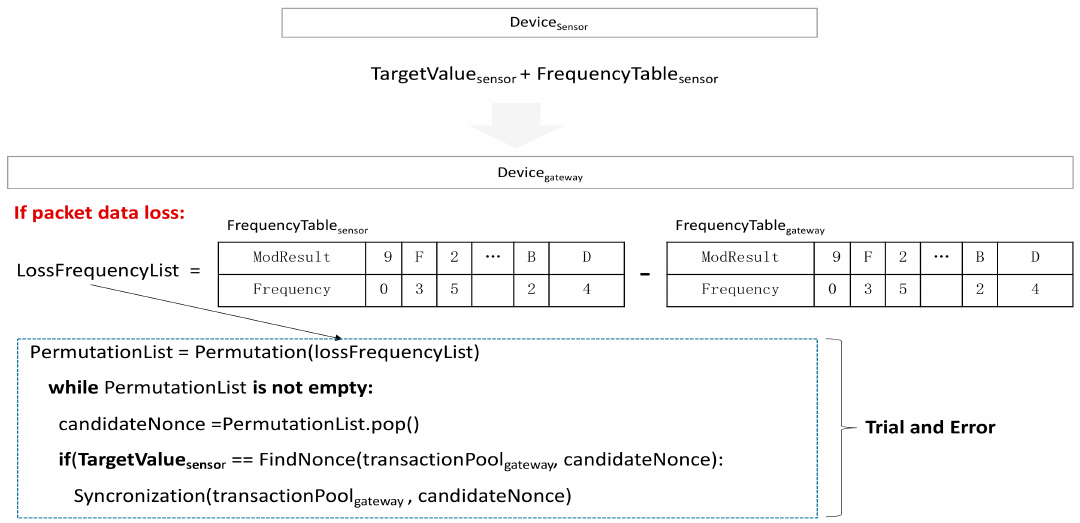
Figure 9. TransactionPool Synchronization.